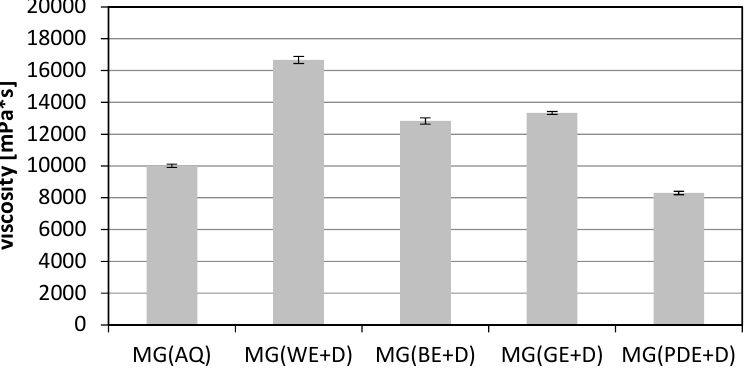
Figure 6. Viscosity of model wash gels, where: MG(AQ)—model gel containing water in place of extract, MG(WE+D), MG(BE+D), MG(GE+D), MG(PDE+D)—model gels containing 10% ( w / w ) of appropriate extracts. The final result was the arithmetic mean of five independent measurements.